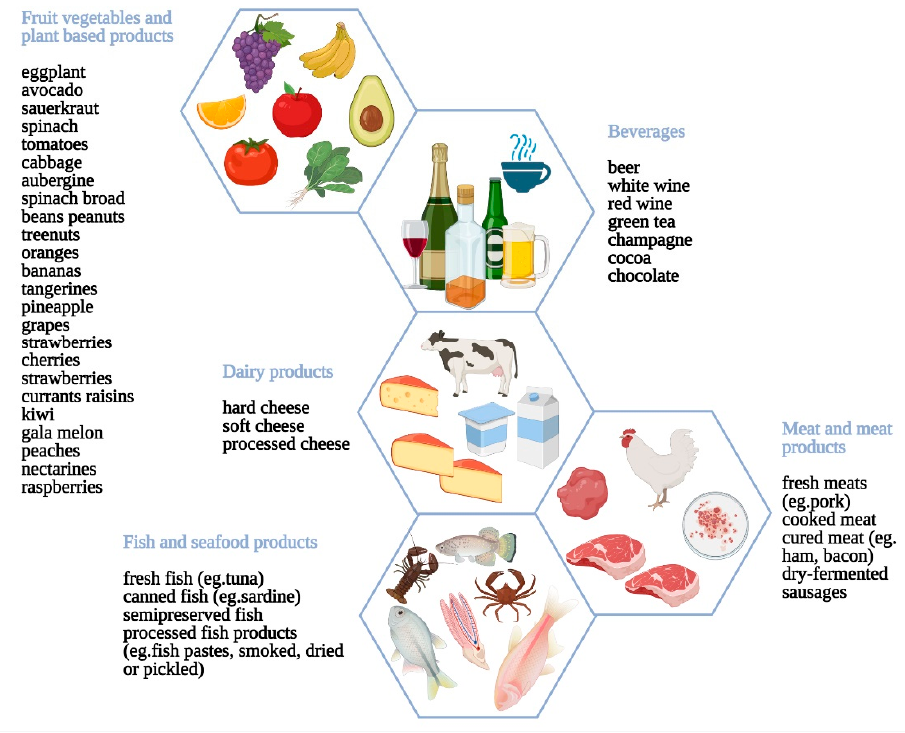
Figure 5. Presence of histamine and other biogenic amines in a wide range of foods.